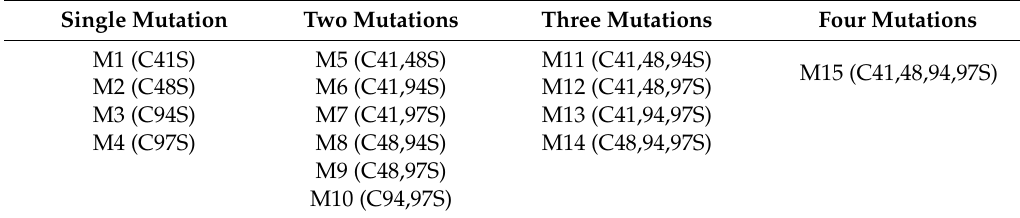
Figure 8. Binding assays between chIL-2 monomer / dimer and chIL-2R in vivo. ( A ), ( B ) and ( C ) were immunofluorescence analyses of the T cells bound hexa-His tagged monomeric or dimeric chIL-2 by flow cytometry using FITC-conjugated anti-CD4 (CD4 FITC) and Alexa Fluor 647-conjugated anti-hexa-His (6 × HisTag AF647) antibodies before ( A ) or post stimulation of monomeric ( B ) or dimeric ( C ) chIL-2. The proportions of detected T cells with each antibody were plotted as a bar graph ( D ). Ctrl, the proportions of T cells without the stimulation of any form of chIL-2; Monomer, the proportions of T cells that stimulated by sf9 source of monomeric chIL-2 protein; Dimer, the proportions of T cells that stimulated by sf9 source of dimeric chIL-2 protein. The plotted data represent mean values ± standard deviation, and are the average of three independent experiments. Table 1. The mutants with various combinations of Cys